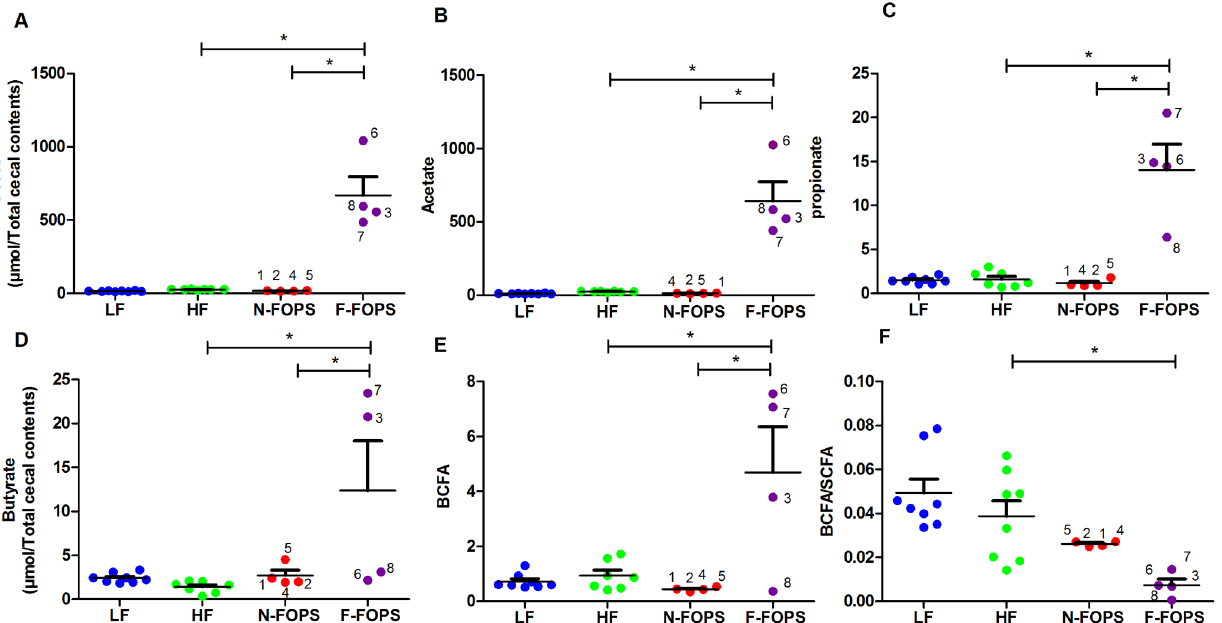
Fig 2. Cecal SCFA in mice after 8 weeks of feeding. SCFA (A), acetate (B), propionate (C), butyrate (D), BCFA (E), SCFA/SCFA ratio (F); data are presented as mean ± SEM; n = 8 mice/group for HF and LF; n = 4 mice/group for N-FOPS and F-FOPS; mouse numbers are shown for FOPS mice to track individual mice across figures; * indicates a significant difference (p < 0.05) between the indicated treatments using Bonferroni ’ s multiple comparison test with the following comparisons: LF vs. HF; HF vs. N-FOPS; HF vs. F-FOPS; F-FOPS vs. Y-FOPS.